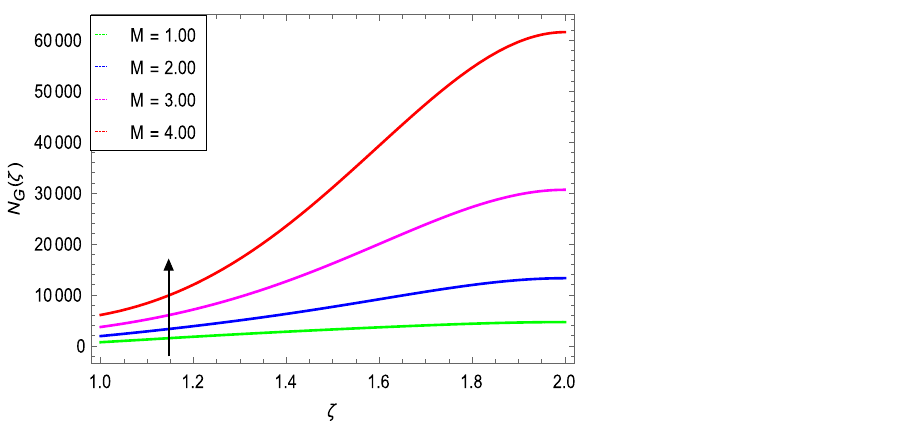
Figure 20. NG (ζ) as a function of M .